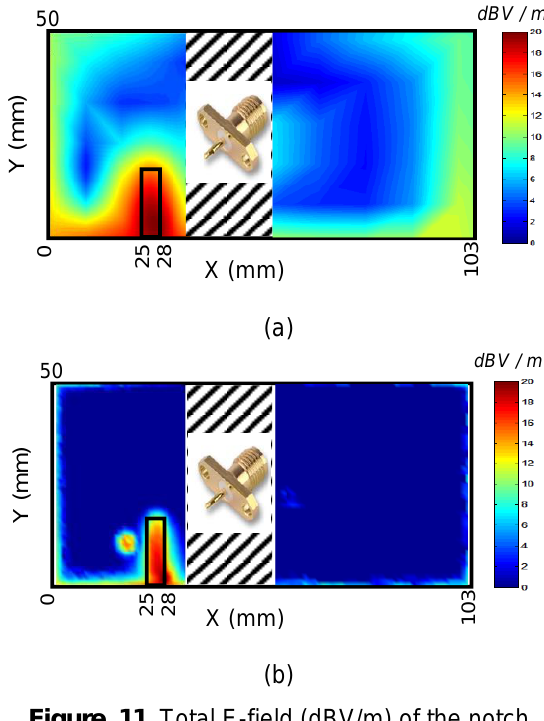
Figure. 11. Total E-field (dBV/m) of the notch antenna at 560 MHz (a) Measurement (b)